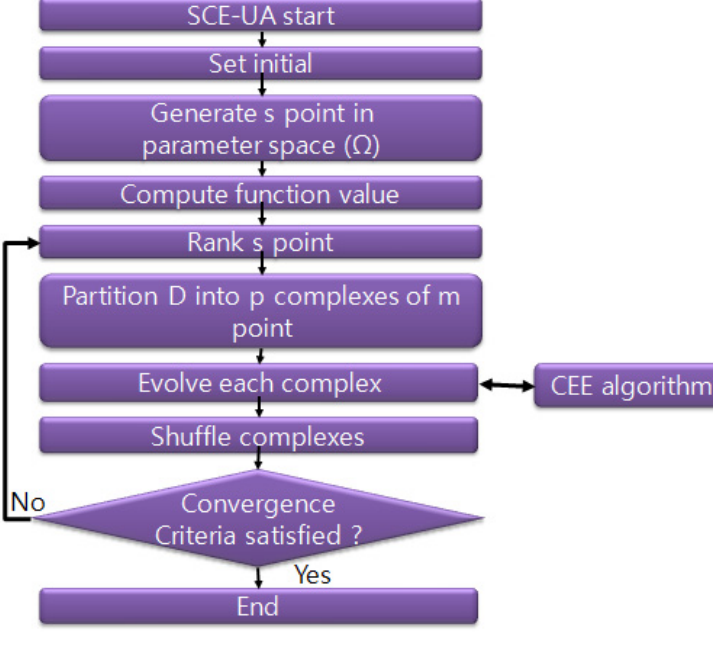
Figure 3. Flow chart of SCE-UA algorithm